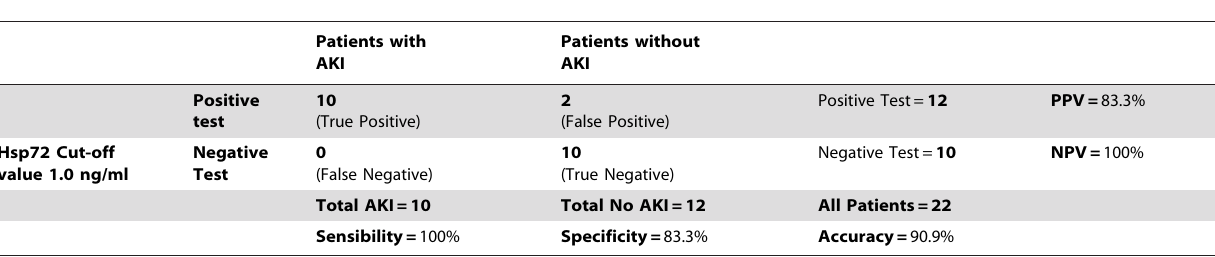
Table 2. Validation test for Hsp72 in a similar population in ICU.